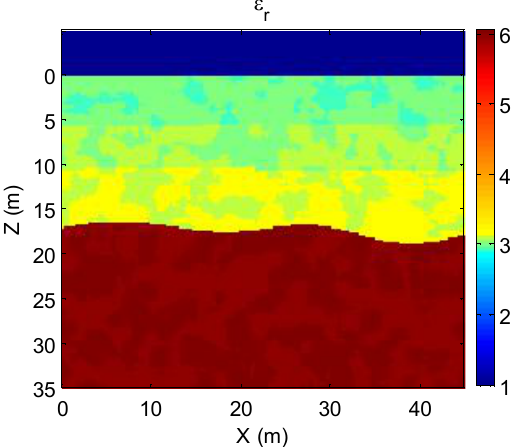
Figure 3. Relative permittivity model